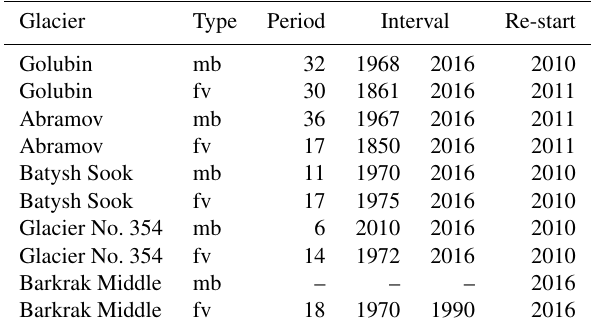
Table 1. Information of observed glaciers and type of measurements currently available from WGMS (2013) for mass balance (mb) and frontal variation (fv), see Fig. 1 for